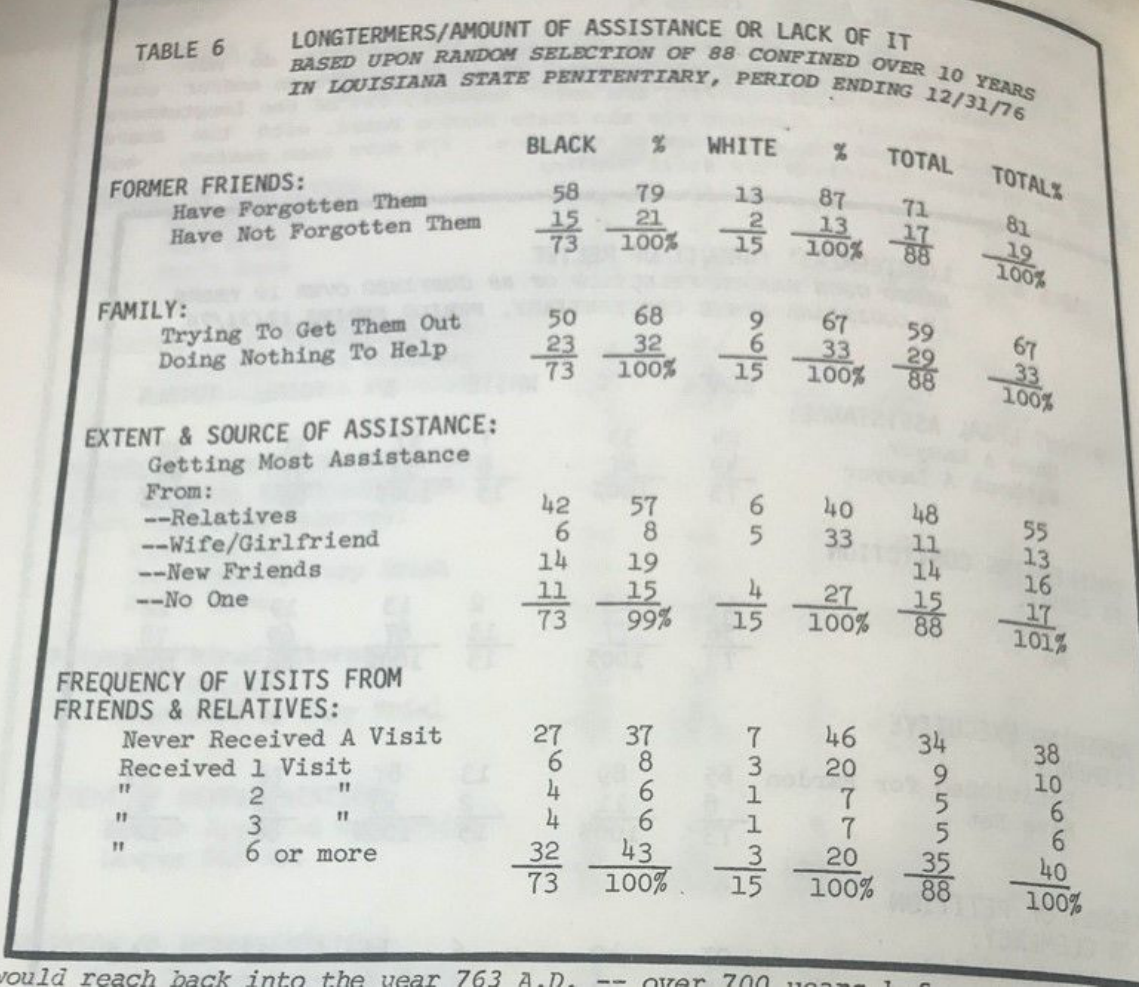
Figure 1. The Angolite “longtermers” study, amount of assistance or lack of it, Beinecke Rare Book and Manuscript Library,